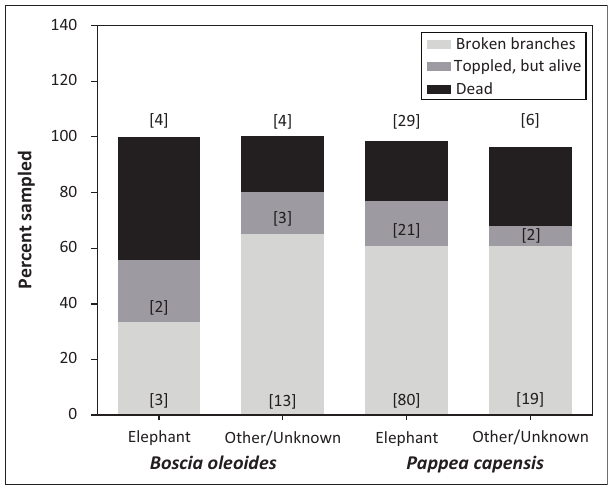
FIGURE 3: Intensity of elephant impact on woody trees, distinguishing between individuals with broken branches, toppled trees and those that suffered mortalities. Numbers in brackets indicate the number of individuals of each species recorded.